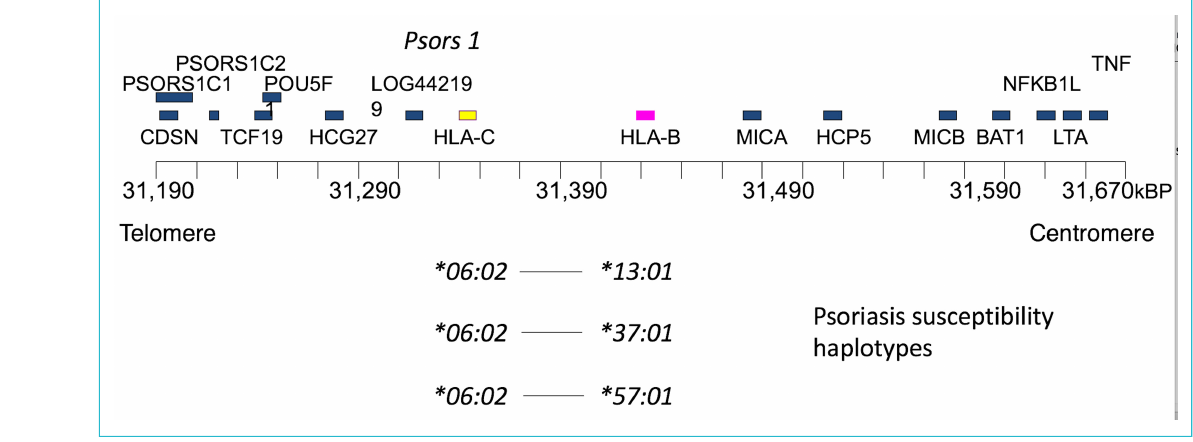
Figure 3: Psoriasis HLA genetics, showing a more detailed map of the class I region around the HLA-B and HLA-C loci, in the region of Psors 1 , the major candidate region for psoriasis susceptibility identified by earlier linkage studies. More recent studies primarily map susceptibility into the HLA-C locus, eliminating some of the depicted candidate loci. More specifically, susceptibility has been shown to be associated with the HLA-C*06:02 allele, which is present at a frequency ~60% in most series ascertained on psoriasis. The frequency increases to ≥70% if late onset disease is eliminated. Three main conserved PsC susceptibility haplotypes containing C*06:02 are